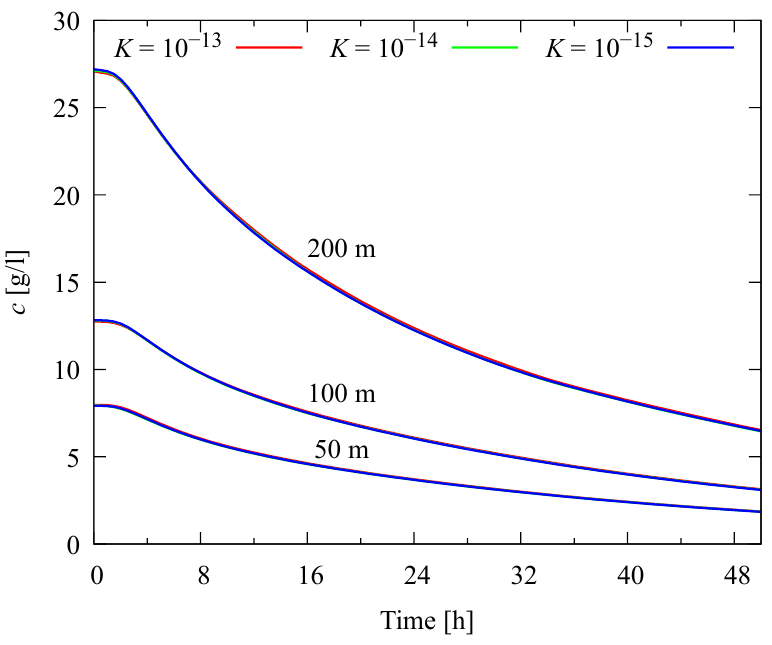
Figure 11. Variation of soil impurity concentration with time at a depth of 2 m at distances of 50, 100 and 200 m for different permeabilities after the cessation of brine disposal.